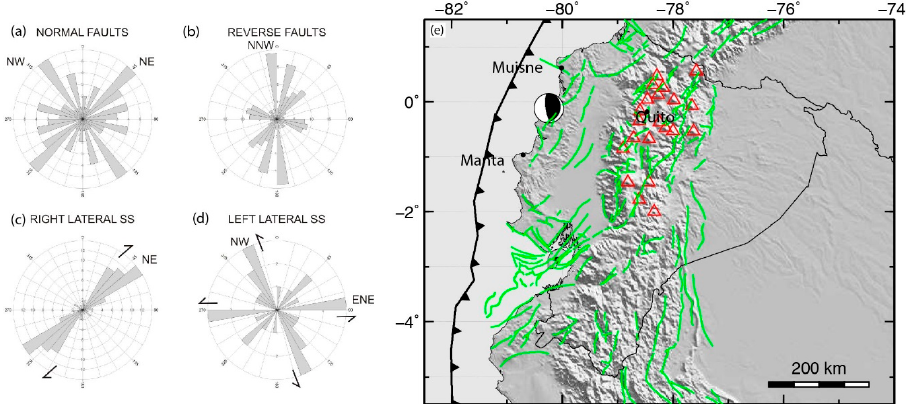
Figure 5. Rose diagrams of the frequency of faults orientation according to the fault type, extracted from the Ecuador Active Faults database of [50]. ( a ) Normal faults, two main sets with NE- and NW trending; ( b ) Reverse faults, showing a main orientation towards NNW; ( c ) Right Lateral strike-slip, with a main direction of NE-trending; ( d ) Left lateral strike slip faults with two conjugate sets, NW-SE and ENE-WSW trending faults. In ( c ) and ( d ), arrows indicate the sense of the movement for strike slips; ( e ) Fault segments (green lines) from the Ecuador Active Faults database of [50]. Holocene volcanoes from http://volcano.si.edu/search_volcano.cfm are shown as red triangles. The compilation of information on the selected volcanoes (Tungurahua, Guagua Pichincha, Reventardor, Sangay and Cotopaxi) revealed that most of them have vertical or sub-vertical magma paths, with NE-SW azimuths in most of them (see Supplementary Table S4). We use this average orientation to estimate the induced normal stress change (∆σ ) on each volcano magma pathway.